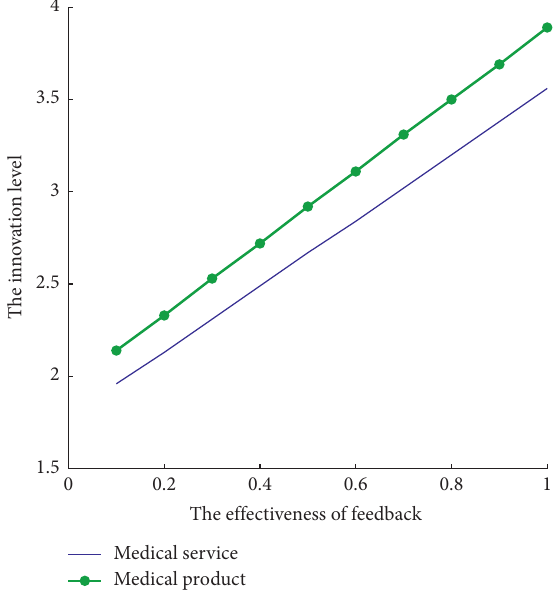
Figure 5: The impacts of feedback on the innovation level of medical products in the centralized strategy.